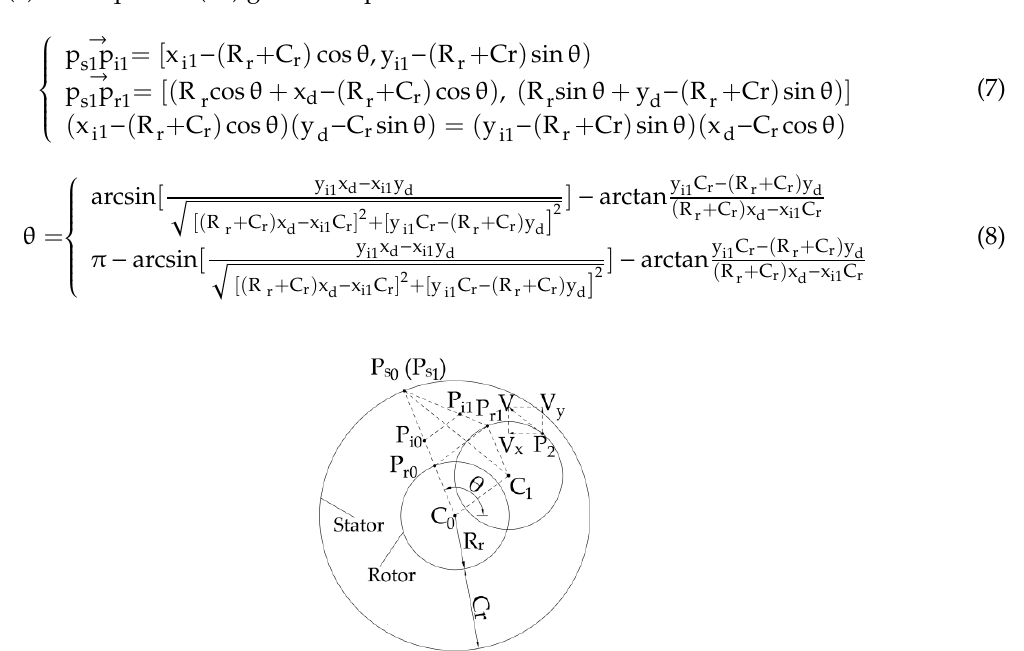
Figure 4. Diagram of the grid nodes moving.